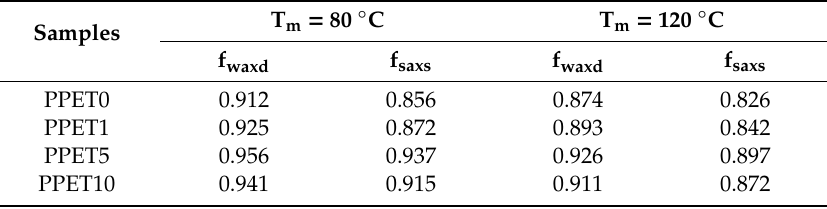
Table 2. Orientation degree fitted from 2D-WAXD and SAXS.